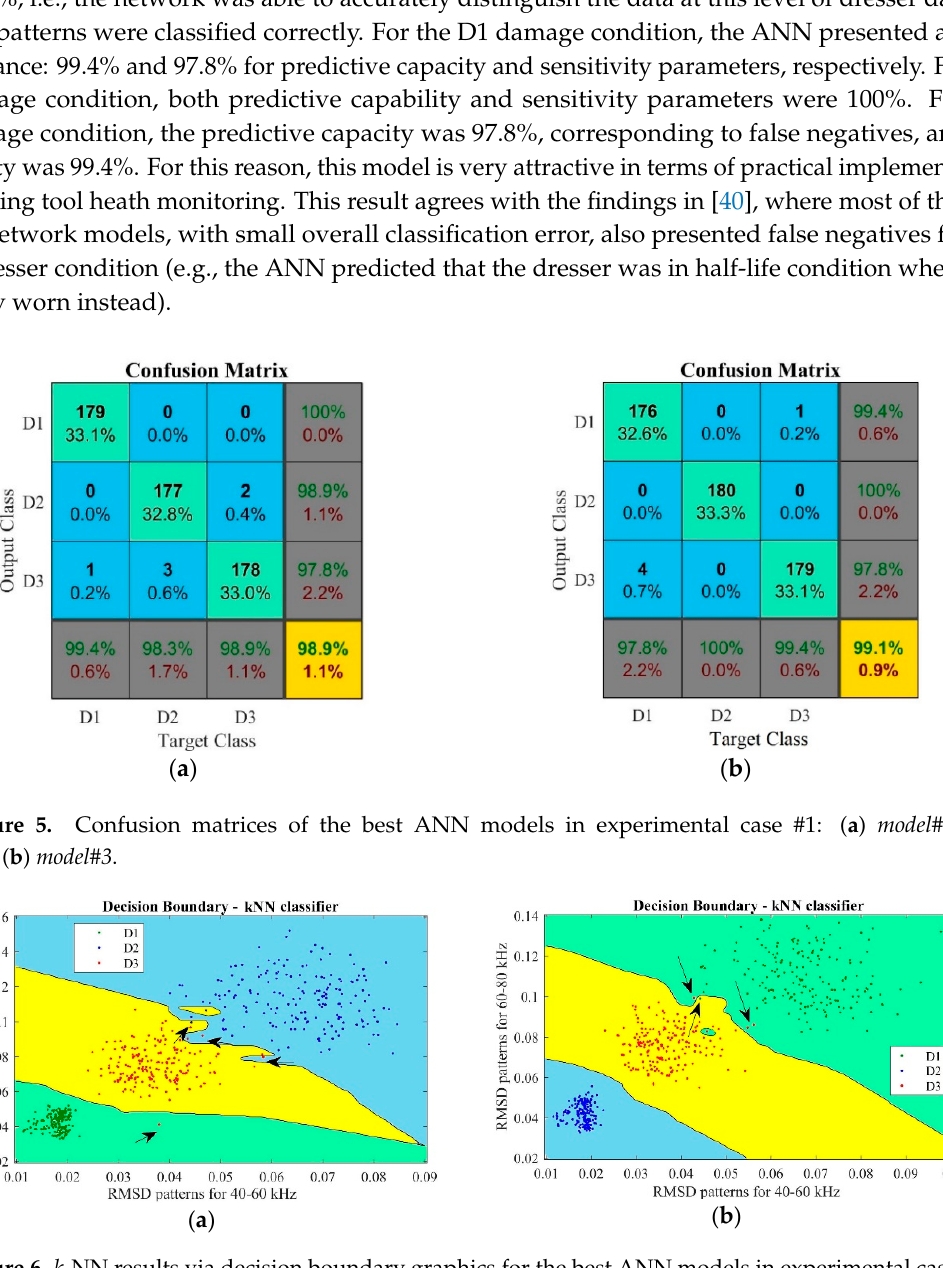
Figure 6. k -NN results via decision boundary graphics for the best ANN models in experimental case #1: ( a ) model#1 ; and ( b ) model#3 .